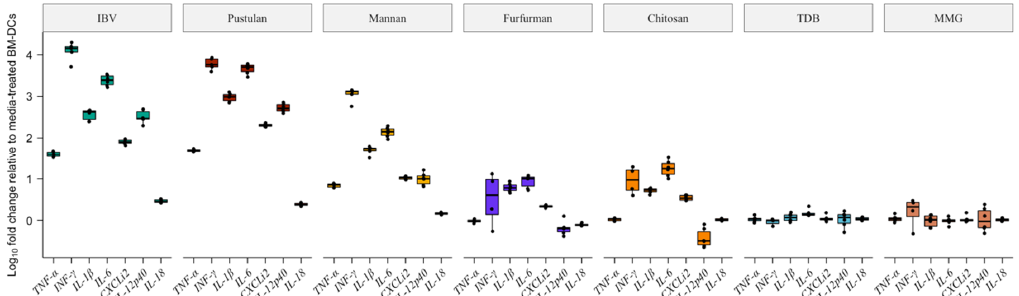
Figure 2. BM-DC expression of the proinflammatory cytokines at 3 h post stimulation. RNA was purified from BM-DCs 3 h post stimulation with UV-inactivated IBV (IBV), pustulan, mannan,